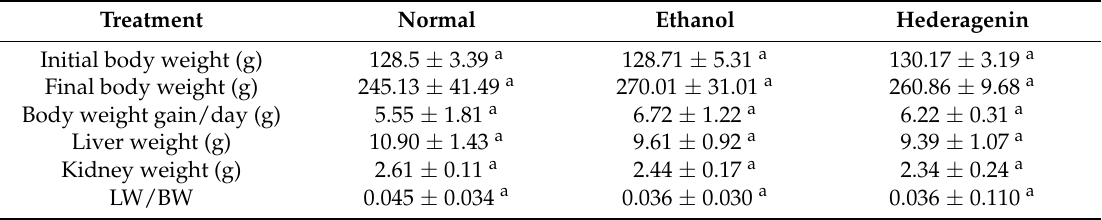
Table 1. Effects of hederagenin from Akebia quinata fruit on body weight and liver weight in ethanol-treated rats.